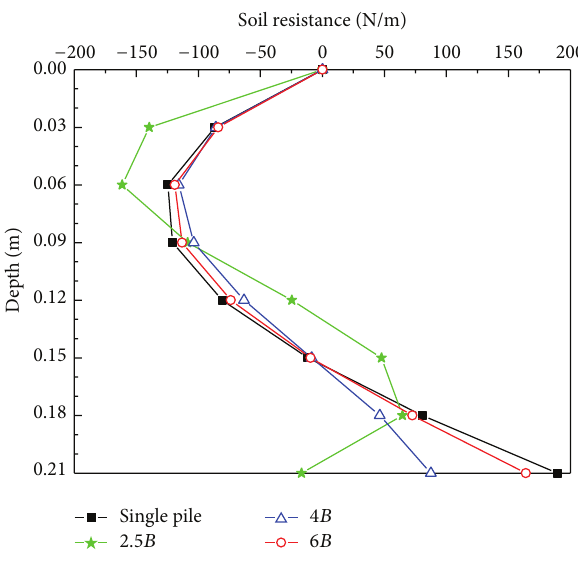
Figure 7: Soil resistance versus depth curves from the active